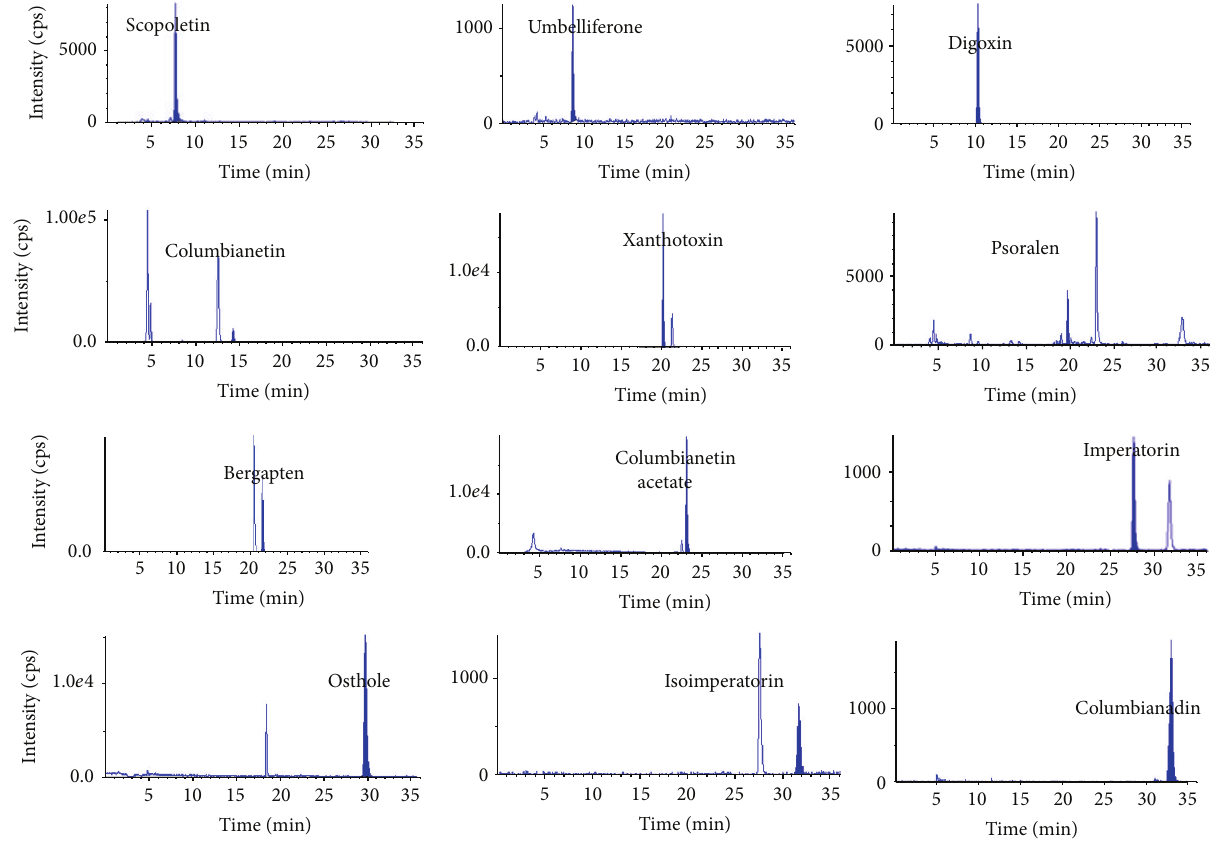
Figure 3: Typical MRM of Radix Angelicae